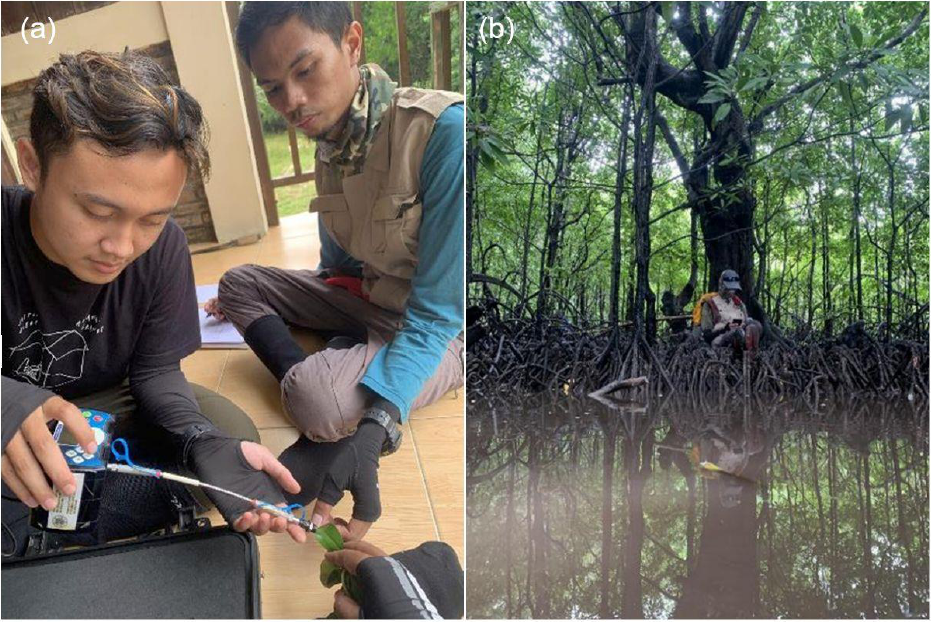
Figure 3. Field data collection: ( a ) spectral reflectance measurement of the targeted mangrove species and ( b ) field validation sample collection.